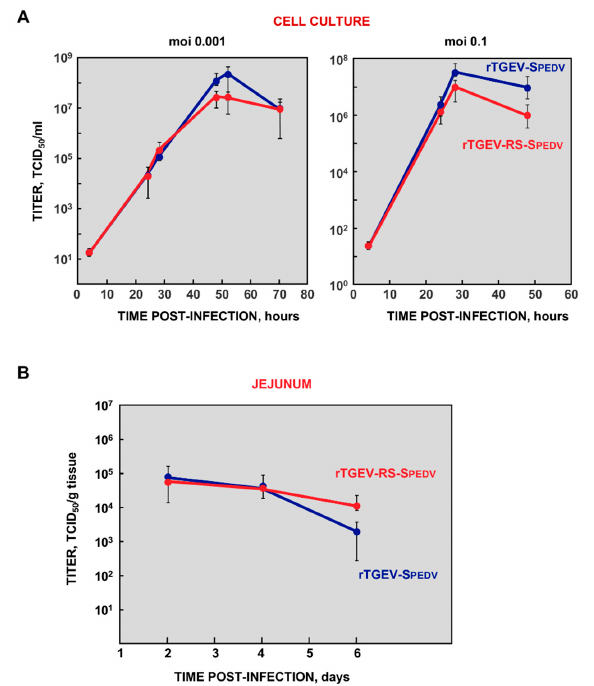
Figure 2. Growth kinetics of rTGEV-SPEDV viruses. ( A ) Viral growth in cell cultures. Vero cells were infected with rTGEV-SPEDV (blue) or rTGEV-RS-SPEDV (red) viruses at MOI of 0.001 (left panel) or 0.1 (right panel). Aliquots of culture supernatants were recovered at the indicated times post-infection, and virus titers analyzed. The values represent viral titers from three independent experiments. ( B ) Replication of rTGEV-S PEDV viruses in enteric tract. Five-day-old piglets were orally inoculated with 10 6 TCID 50 /piglet. Jejunum samples were taken at the indicated times post-infection, and virus present in the samples was titrated. The values represent viral titers from three different animals. Error bars represent the standard deviation for each value.